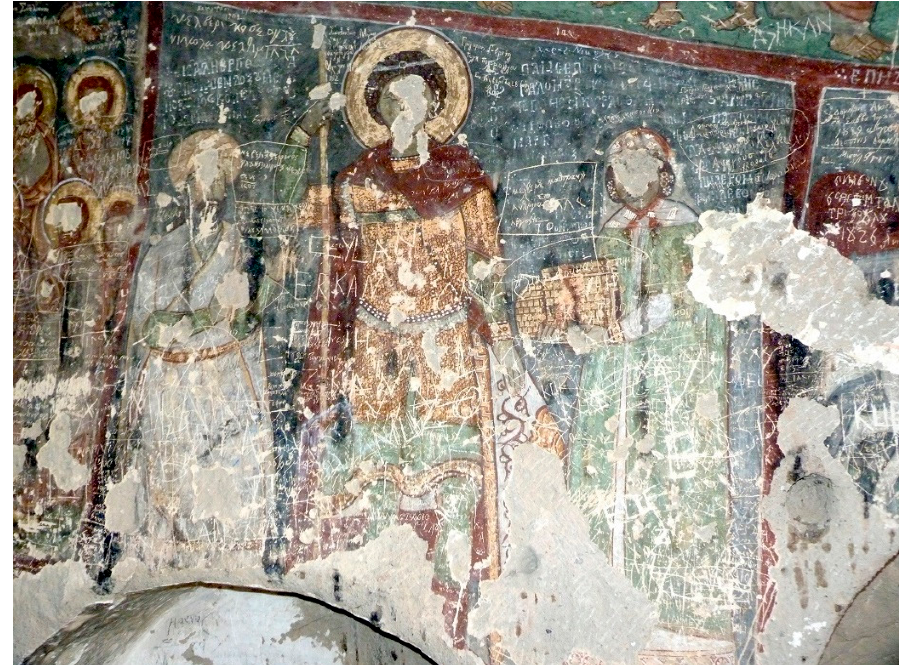
Figure 1. St George between Emir Basil Giagoupes and his wife, kyra Thamar. Kirk Dam Alti Kilise or St George at Belisirma, Ihlara Valley (Cappadocia, Turkey), 1284–1295. © Author.